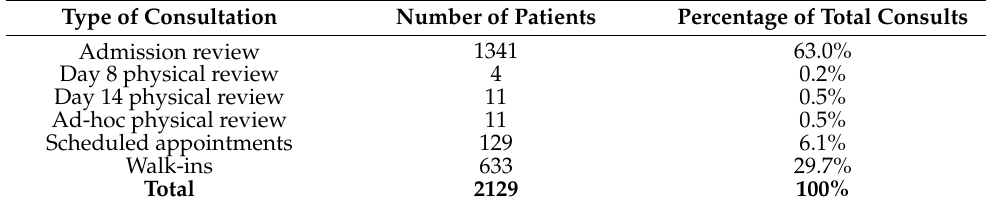
Table 1. Number of patients seen at the CCF/CRF@Big Box from 4 July 2020 to 2 August 2020 based on type of medical consultation.